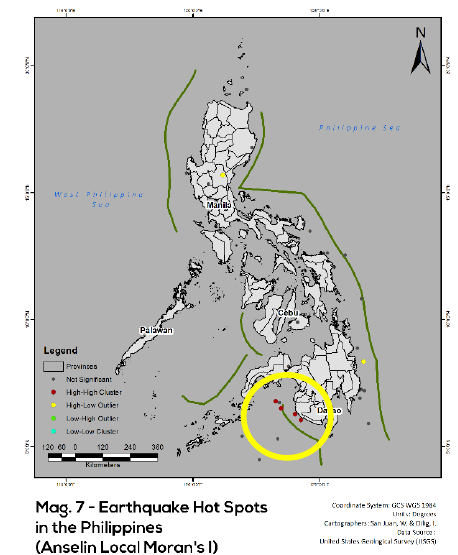
Figure 13. Mag.7-Earthquake Clusters in the